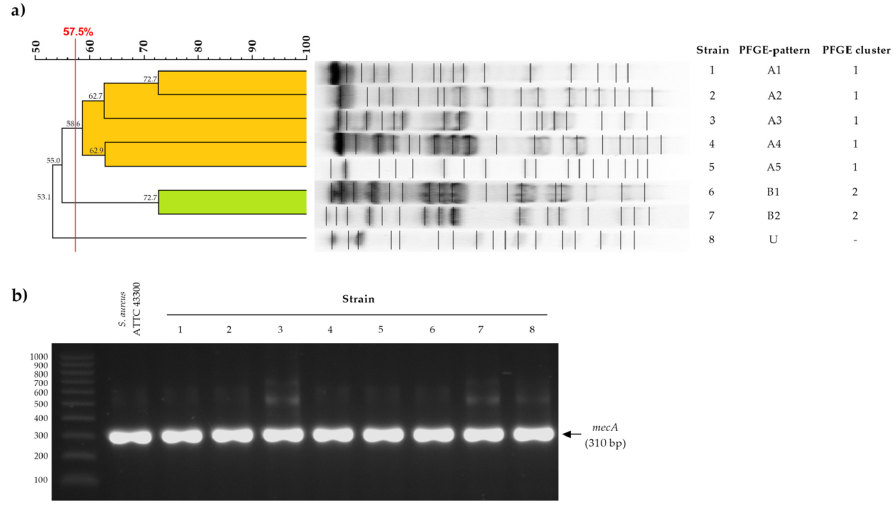
Figure 1. Pulsed-field gel electrophoresis ( a ) and polymerase chain reaction amplification of mecA gene; ( b ) results of methicillin-resistant Staphylococcus aureus strains. U—unique strain.